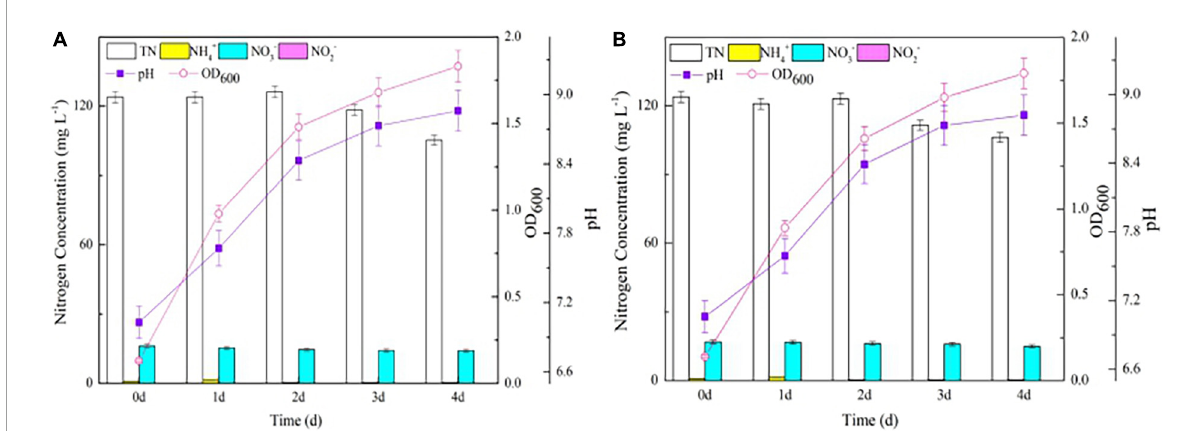
FIGURE1 The growth curve and nitrogen transformation performance of strain Y-9 in organic nitrogen medium at 15 ◦ C. (A) The wild-type strain Y-9. (B) The (cid:77) nirBD strain Y-9.